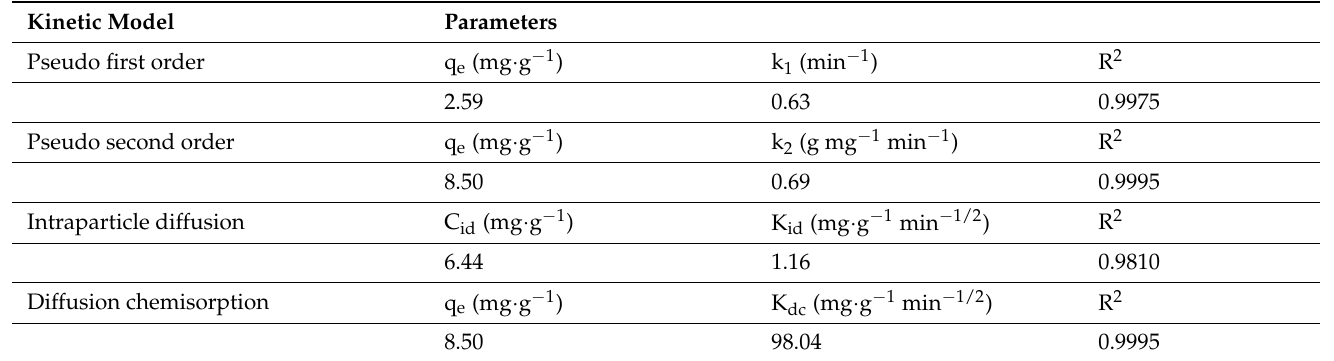
Figure 9. ( a ) Pseudo-first order; ( b ) pseudo-second order; ( c ) intraparticle diffusion; ( d ) diffusion- chemisorption plots for adsorption of CTM onto citric-acid-modified Moringa peregrina leaf adsorbent at room temperature. Table 4. Kinetic parameters for adsorption of CTM onto citric-acid-modified Moringa peregrina leaf adsorbent at room